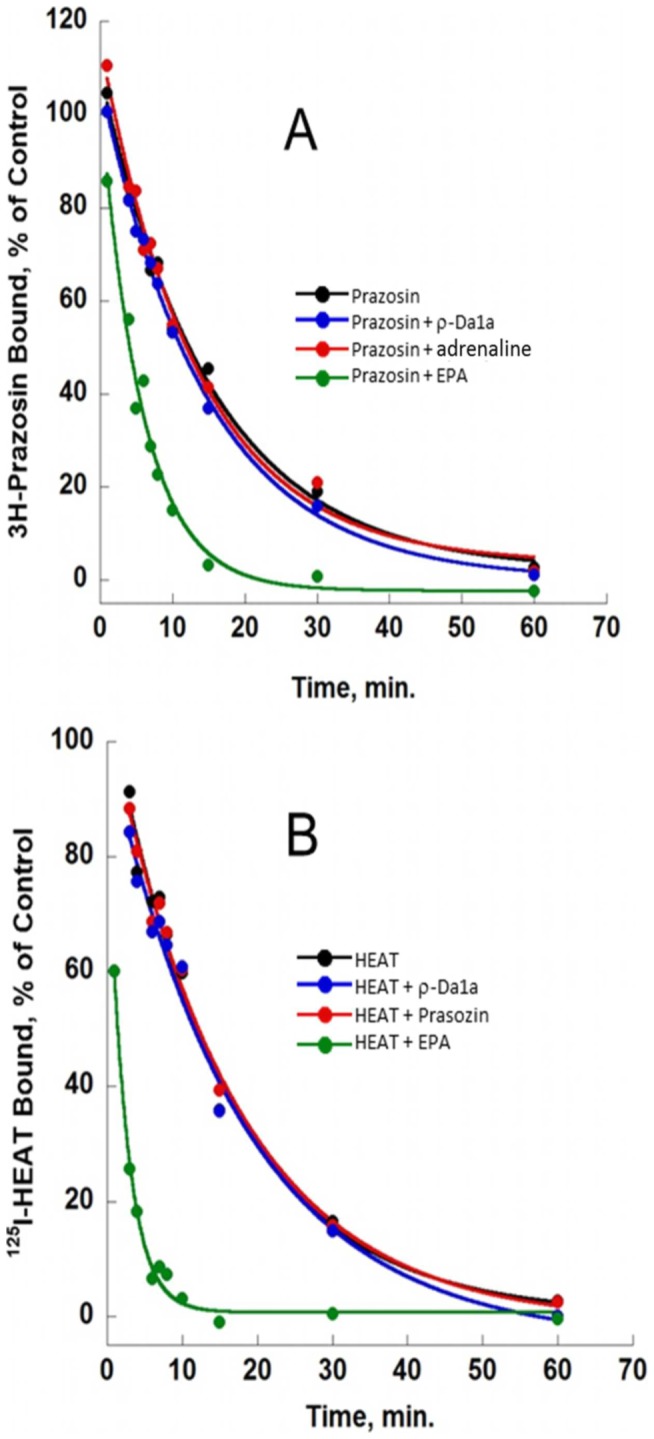
Influence of various ligands on 3H-prazosin and 125I-HEAT dissociation.Panel A: Dissociation of 3H-prazosin (2 nM) binding to α1A-AR (1 µg) in the presence of prazosin (10 µM, black), prazosin plus ρ-Da1a (2.5 µM, blue), prazosin plus adrenaline (2 mM, red) and prazosin plus EPA (150 µM, green). Panel B : dissociation of 125I-HEAT (0.4 nM) binding to α1A-AR (0.2 µg) in the presence of HEAT (5 µM, black), HEAT plus ρ-Da1a (2.5 µM, blue), HEAT plus prazosin (10 µM, red) and HEAT plus EPA (150 µM, green). n = 2.